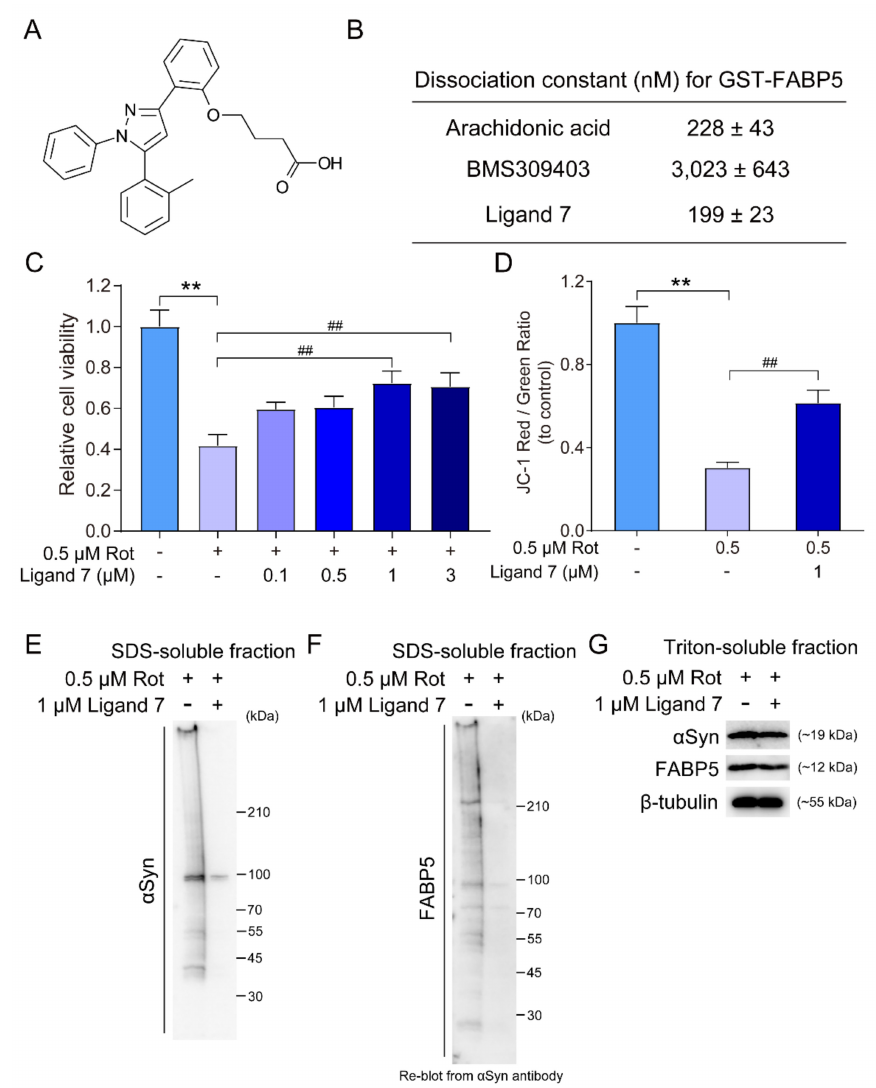
Figure 5. Effects of FABP5 ligand 7 on cell death and α Syn oligomerization and aggregation. All experiments in Figure 5 were carried in α S/F5 -transfected cells. ( A ) Chemical structure of ligand 7. ( B ) Dissociation constants ( Kd values, nM) of arachidonic acid, BMS309403, and ligand 7 for GST-FABP5 [24]. ( C ) α S/F5-transfected cells were exposed to 0.5 µ M rotenone and the indicated concentrations of ligand 7 for 48 h. Cell viability was measured using CCK-8 assays. Results are presented as means ± SEM ( n = 6 parallel cell experiments). ** p < 0.01, vs. non-rotenone-treated cells; ## p < 0.01, vs. rotenone-treated cells without ligand. ( D ) Graphs demonstrating quantification of the JC-1 ratio (red/green). Results are presented as means ± SEM ( n = 5 parallel cell experiments). ** p < 0.01, vs. non-rotenone-treated cells; ## p < 0.01, vs. rotenone-treated cells without ligand. ( E , F ) Representative images of immunoblots developed with antibodies against α Syn and FABP5 in α S/F5 cells treated with ligand 7. Three parallel cell experiments were performed with similar results. ( G ) The monomers of α Syn and FABP5 remain in Triton-soluble fractions. Incubation with β -tubulin antibody was used as a protein-loading